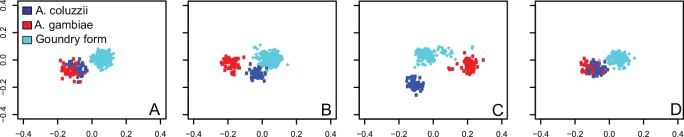
Sliding window PCA indicates that differentiation between A. coluzzii and A. gambiae is restricted to centromeric chromosome regions.Chromosome 3 is analyzed as four non-overlapping windows of 115 uniformly spaced SNPs each, as follows: A) Telomeric and central region of chromosome 3R, B) centromeric region of chromosome 3R, C) centromeric region of chromosome 3L, and D) central and telomeric region of chromosome 3L. Sliding window analysis indicates that A. coluzzii (blue) and A. gambiae mosquitoes (red) cluster together as an apparently panmictic population when typed using non-centromeric markers. In contrast, the Goundry form (turquoise) is distinct from A. coluzzii and A. gambiae across the entire length of both chromosome arms, at both centromeric and non-centromeric sites.